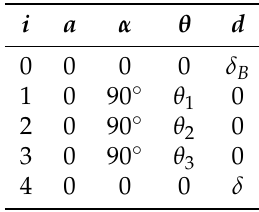
Table 1. Denavit–Hartenberg (DH) parameter